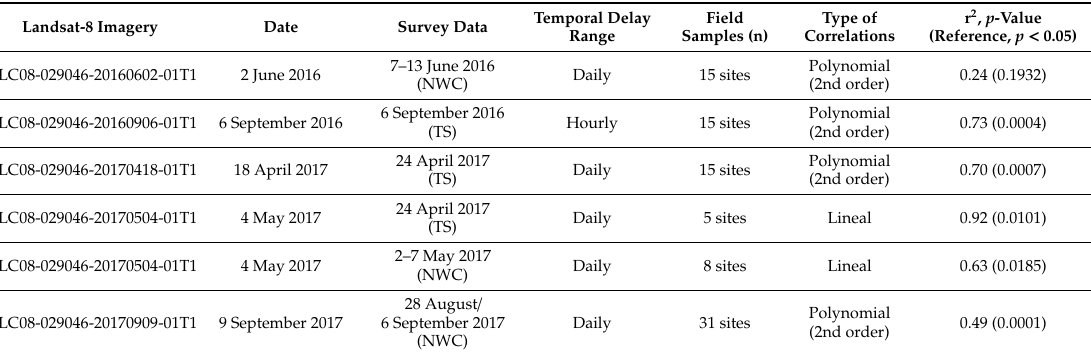
Table 3. Elements and criteria to carry out the model calibration.